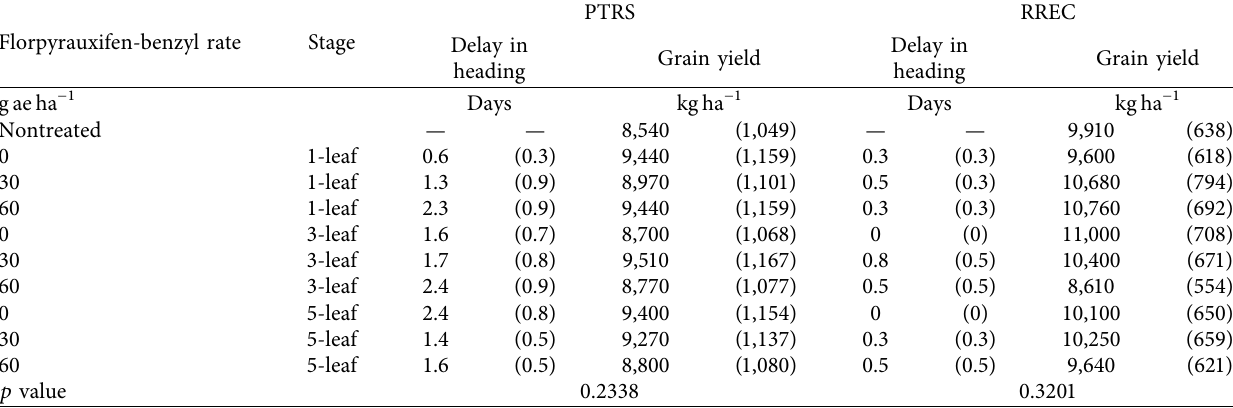
Table 7: Heading and grain yield response of CLXL745 at the Pine Tree Research Station (PTRS) and Rice Research and Extension Center (RREC) a,b,c .